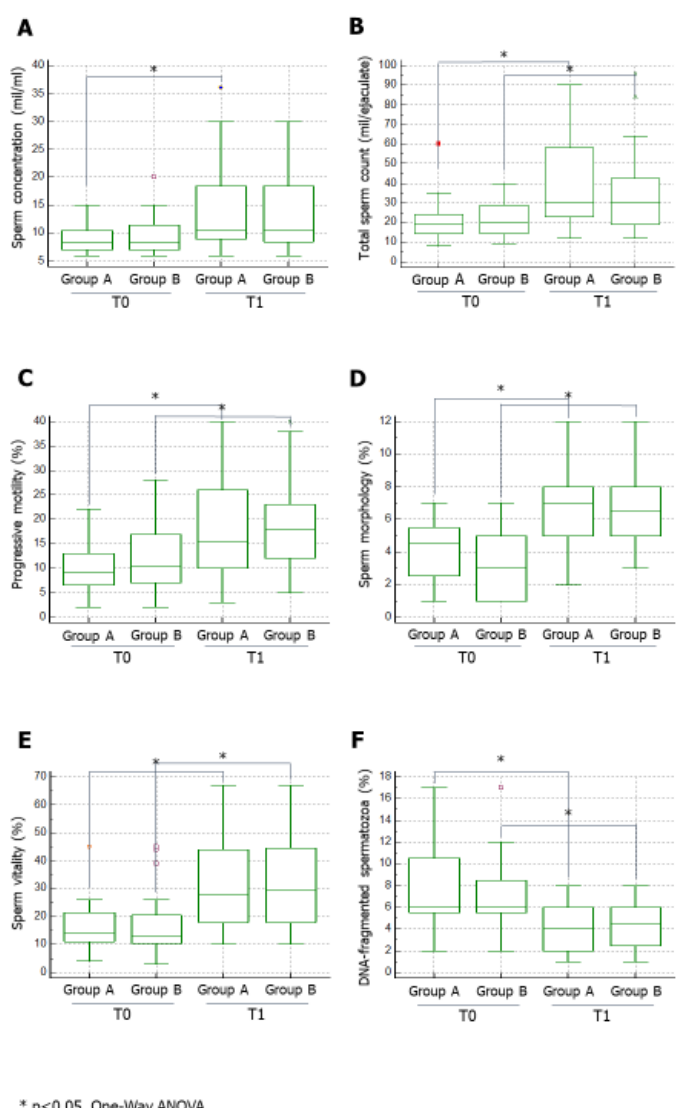
Figure 1. Effects of the two FSH therapeutic schemes on conventional sperm parameters. Data on sperm concentration (panel A ), total sperm count (panel B ), sperm motility (panel C ), sperm morphology (panel D ) and sperm vitality (panel E ) and percentage of spermatozoa with fragmented DNA (panel F ) are shown. FSH, follicle-stimulating hormone. * p < 0.05. Treatment with FSH significantly improved conventional sperm parameters. In